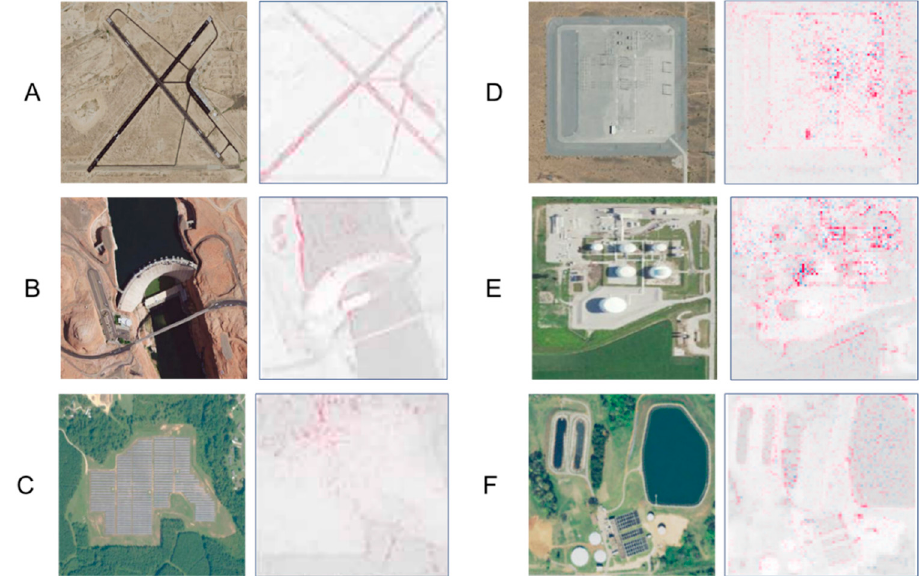
Figure 8. Sample SHAP results, with red indicating areas of positive correlation and blue indicating areas of negative correlation for ( A ) airports, ( B ) hydroelectric dams, ( C ) solar panels, ( D ) substations, ( E ) petrol terminals, and ( F ) water treatment plants. Table 5. SHAP results for the nine CI facility